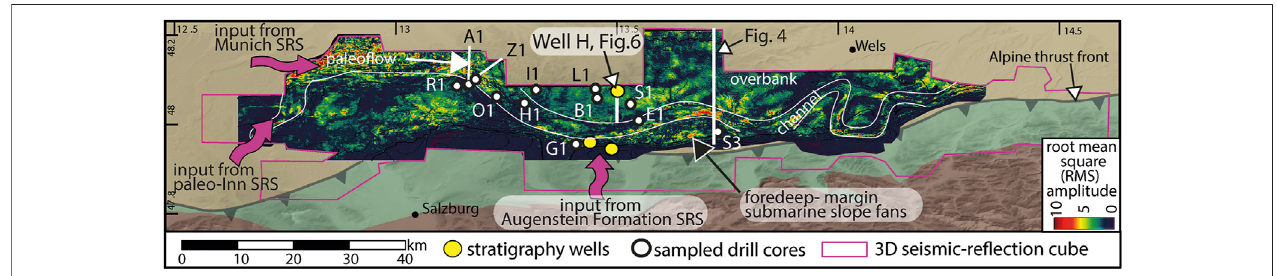
FIGURE 2 | Simpli fi ed geological map of the eastern NAFB in Upper Austria showing the locations of the sampled drill cores, Well H, and the wells with the stratigraphic information in the study area (Hülscher et al., 2019). The inset shows an RMS amplitude map in the Hall Formation outlining the meandering axial channel, the extensive northern overbank deposits, and the slope fans on the southern, tectonically active